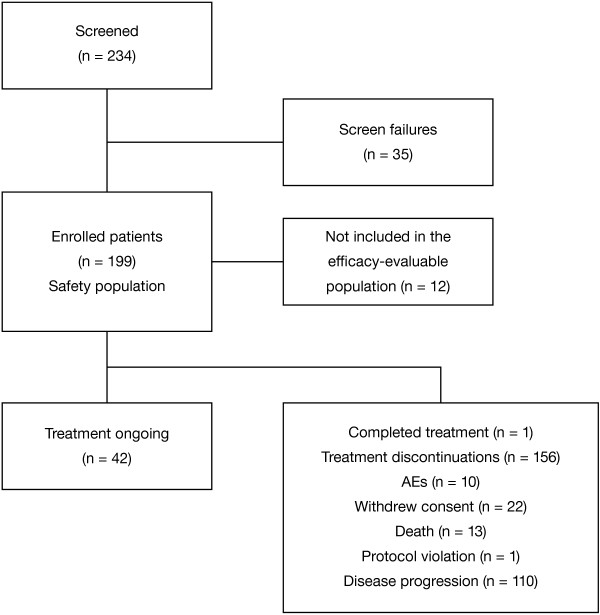
Patient disposition.